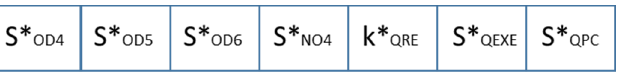
Figure A1. Chromosome structure.